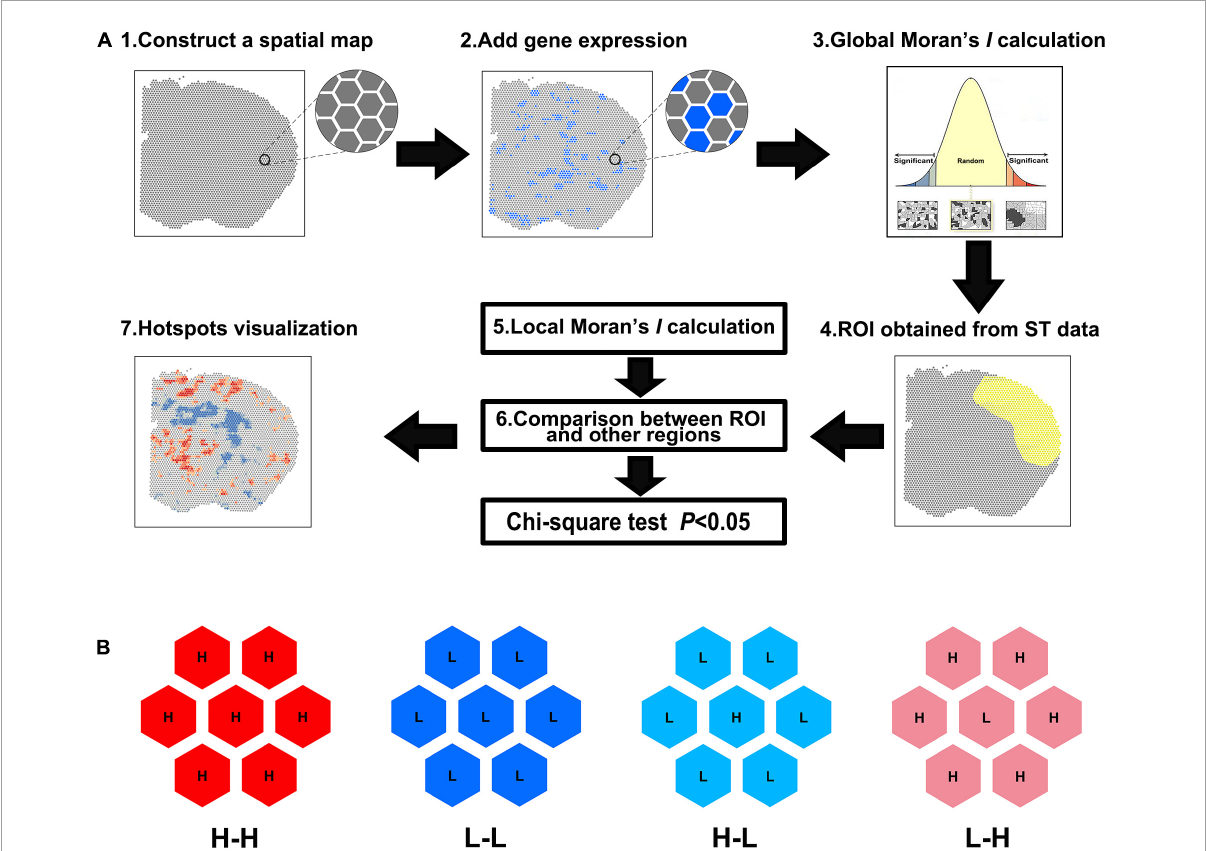
FIGURE1 Spatial analysis of spatial transcriptomics (saSpatial) flow chart. (A) Flow chart of saSpatial. (B) Spatial cluster type. ST, spatial transcriptomics; ROI, region of interest; H-H, high-to-high; L-L, low-to-low; H-L, high-to-low; L-H, low-to-high.